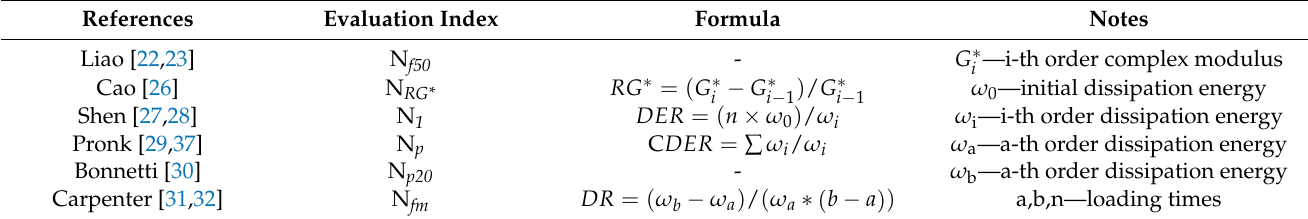
Table 6. Common fatigue life evaluation indicators.